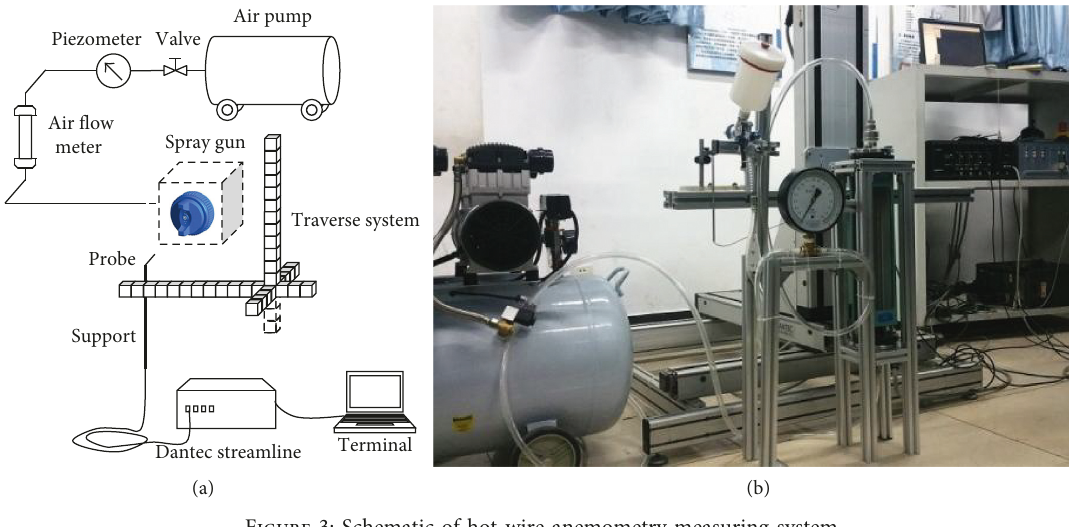
Figure 3: Schematic of hot-wire anemometry measuring system.